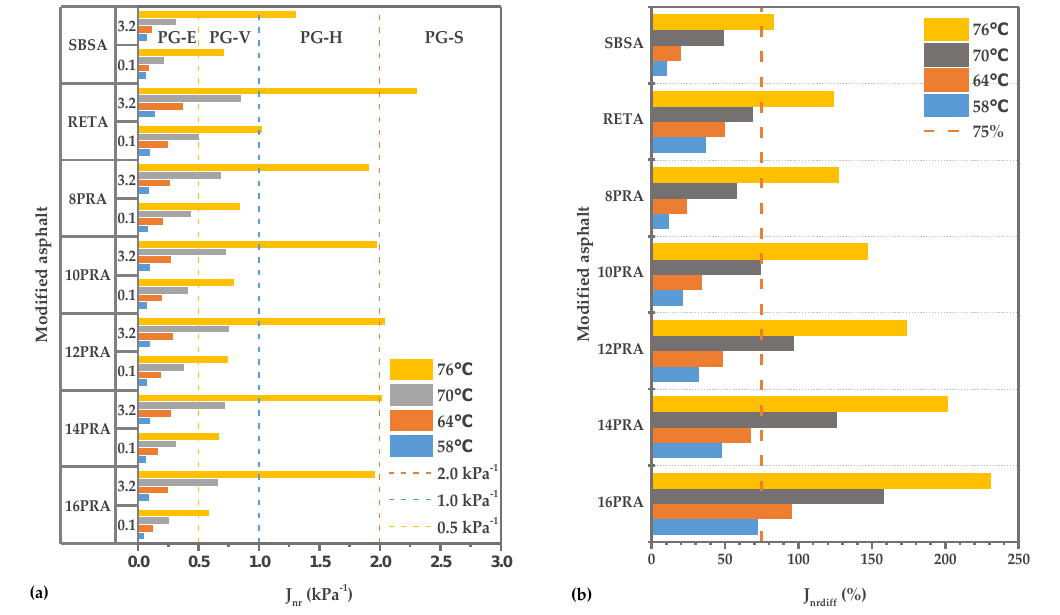
Figure 5. The MSCR test results of modified asphalts: ( a ) J nr 0.1 and J nr 3.2, ( b ) J nrdiff .